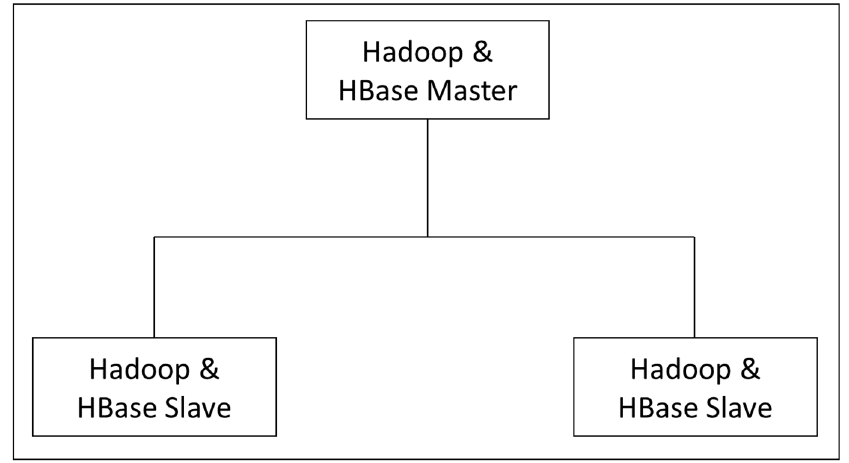
Figure 2. Hadoop and HBase Cluster.